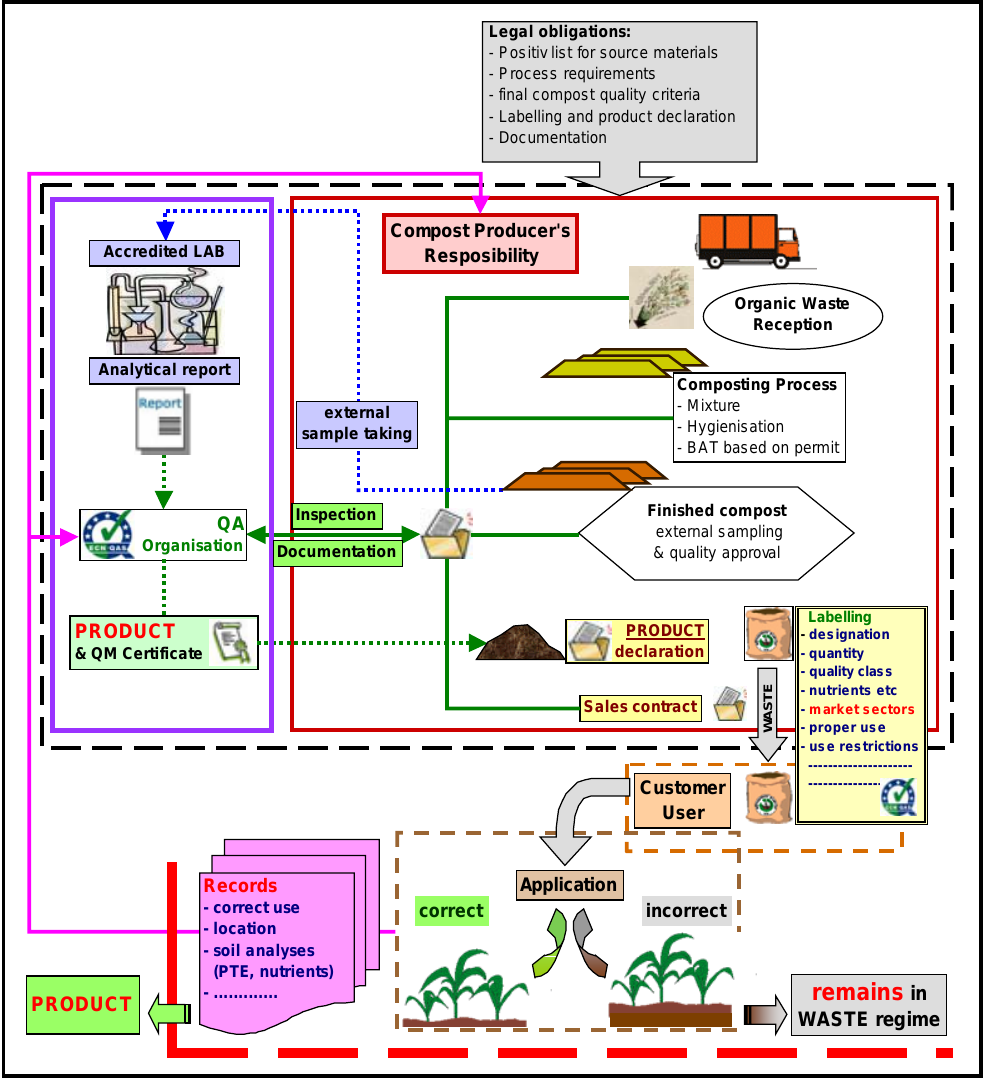
Figure 20: Compost certification scheme including full scale documentation, external inspection and sample taking but also strict elements application approval usually implemented in Quality Protocols (example: Quality Compost Protocol in England and